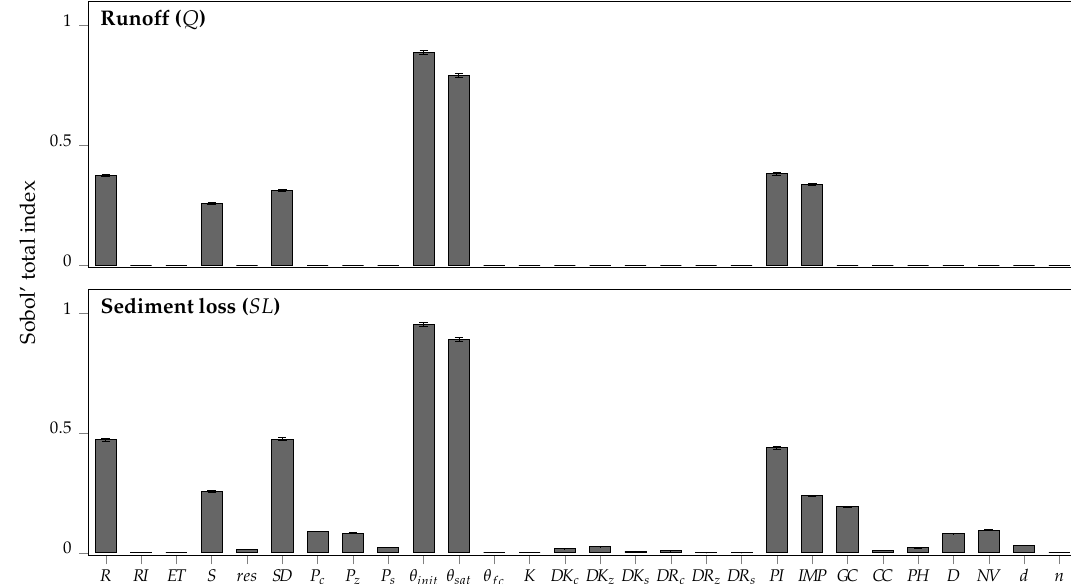
Figure 5. Sobol’ total indices of model input parameters for a single element. The bars indicate the Sobol’ total indices and the error bars indicate the 95% confidence intervals of the indices from